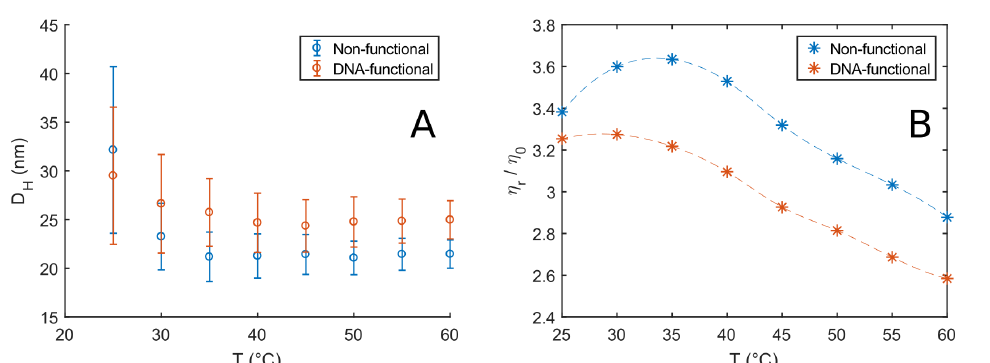
Figure 2. ( A ) Hydrodynamic diameter D H of 5%w/v F108 and F108-N 3 - AA (cid:48) solutions estimated by cumulant analysis at different temperatures. The error bars represent the polydispersity index (PDI). ( B ) Relative viscosities, normalised by the solvent viscosity η 0 measured as function of temperature for the solutions in ( A ) obtained via DLS microrheology: The η r values were obtained from the long-time frequency region of the